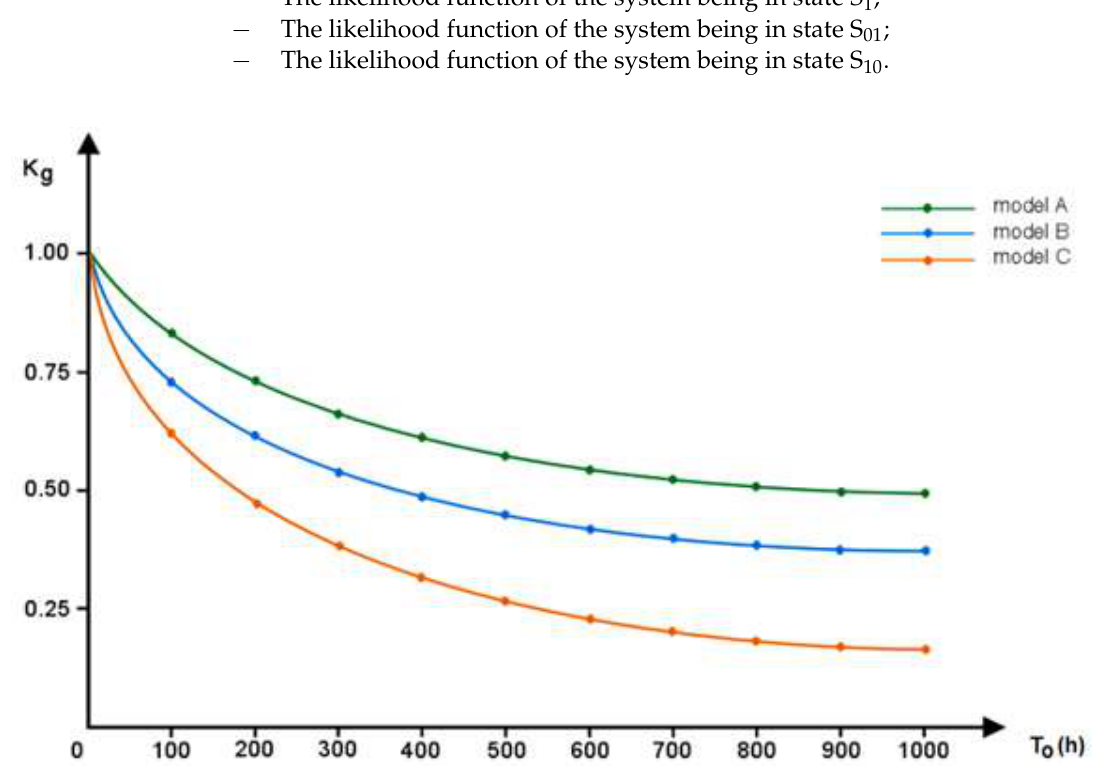
Figure 4. Graph of K g (t) readiness function for the models tested (A, B and C) of the wind farm equipment in the operation process, where T o is the time of the operation process.